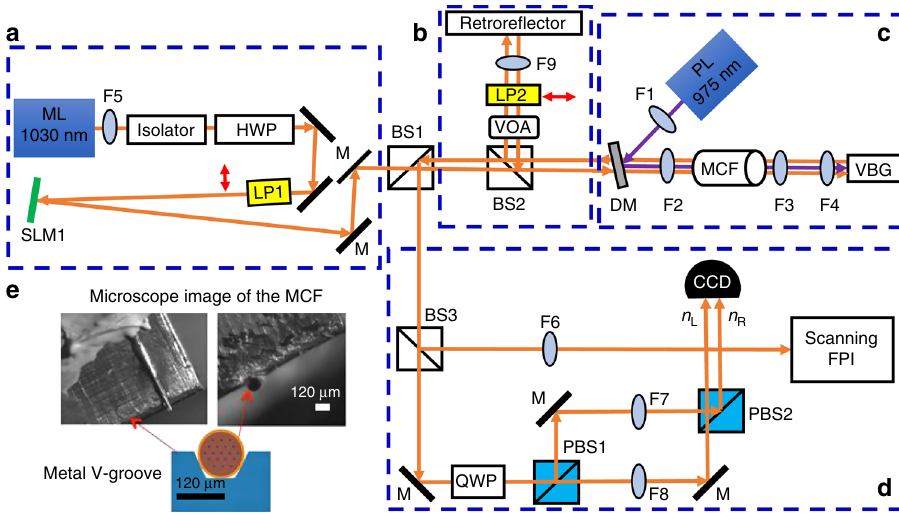
Fig. 4 Experimental setup of the coherent Ising machine (CIM) based on a network of injection-locked MCF lasers. a The polarization of the single frequency master laser (ML) is set to be vertical using a half-wave plate (HWP) and a linear polarizer (LP1). This block is to implement the Zeeman term